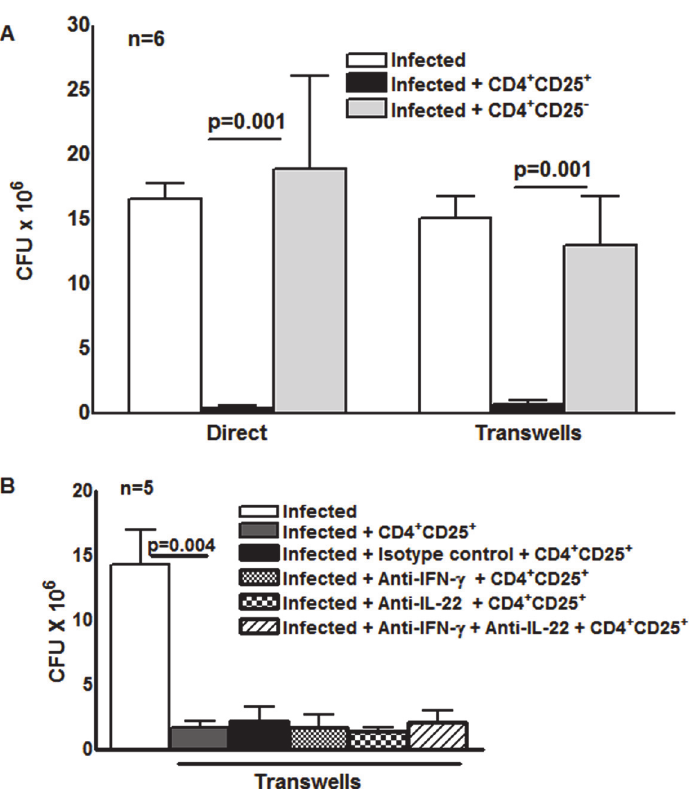
Figure 1. Effect of CD4 + CD25 + Foxp3 + cells on M. tb growth. (A) Freshly isolated CD4 + cells and CD14 + monocytes from 6 individuals with LTBI were cultured with γ -irradiated M. tb H37Rv. After 4 days, CD4 + CD25 + (85 – 90% Foxp3 + ) and CD4 + CD25 - ( < 5% Foxp3 + ) cells were isolated, as outlined in the methods. MDMs from the same donors were infected with H37Rv at a MOI of 1:2.5 (2.5 M. tb to one MDM). After 2 hr MDMs were washed to remove extracellular bacteria and M. tb -expanded CD4 + CD25 + (85 – 90%